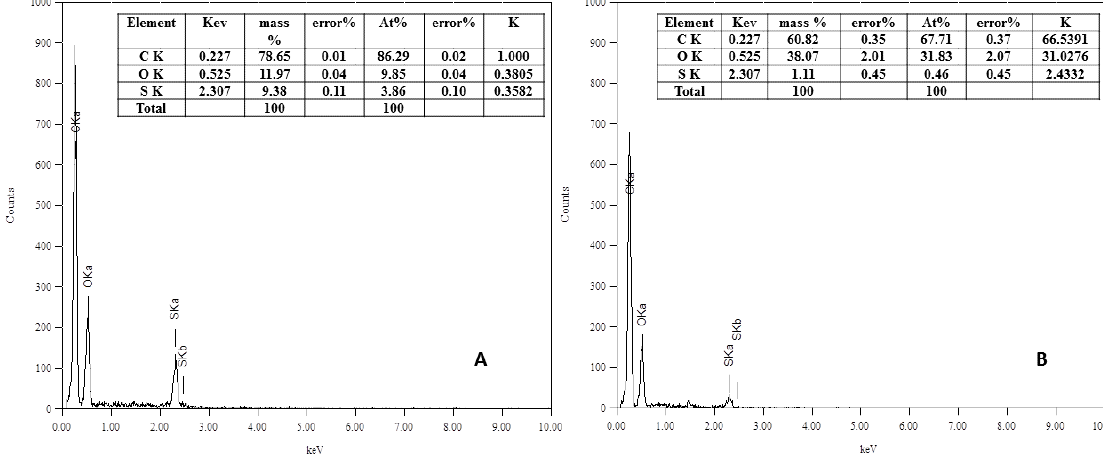
Figure 3. EDX analysis spectra of ( A ) Blank and ( B ) Modified real membrane using 10 mM ferulic acid, 0.5 U∙mL −1 laccase, 45 °C, pH 5 (0.1 M sodium acetate buffer) and 2 h modification time.